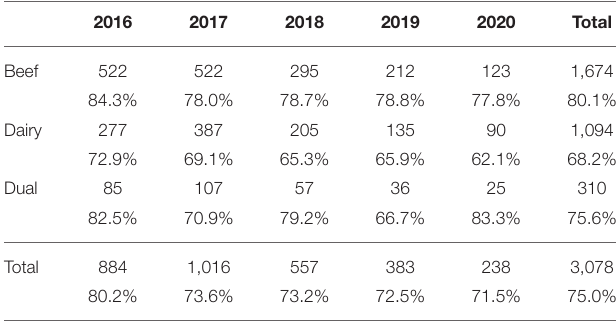
TABLE 8 | Number (%) of cases reporting having found one or more plausible sources of infection by year and herd